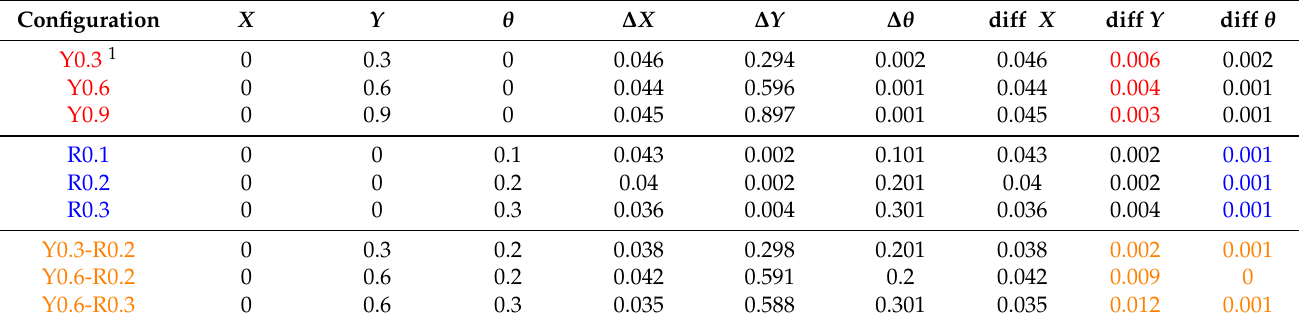
Table 5. The impact of different offset configurations on the accuracy of the alignment algorithm (unit: X ( mm ) , Y ( mm ) , θ ( ◦ )